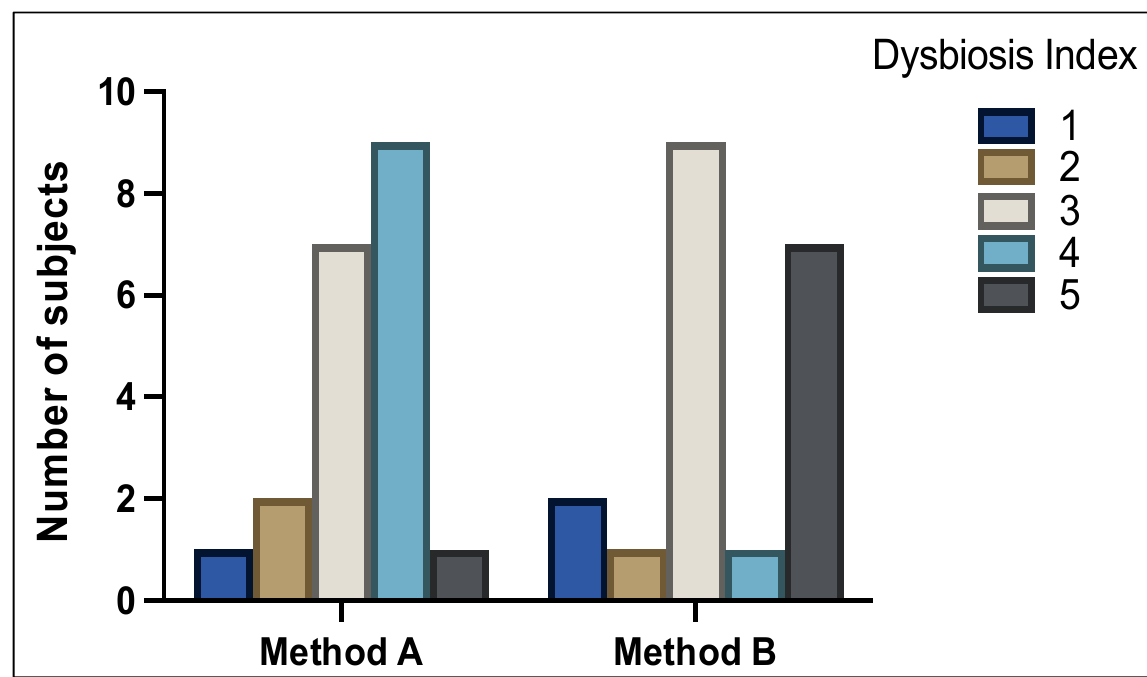
Figure 1. Distribution of Dysbiosis Index (DI) scores 1–5 as determined by GA-map ® Dysbiosis test. High variability of DI can be seen between method A and method B.